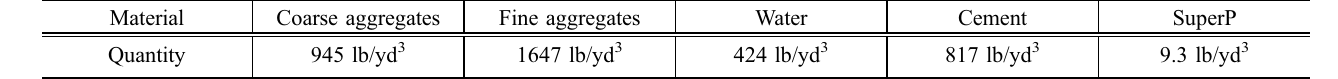
Table 1 Mix proportions for small and full-scale beam specimens.